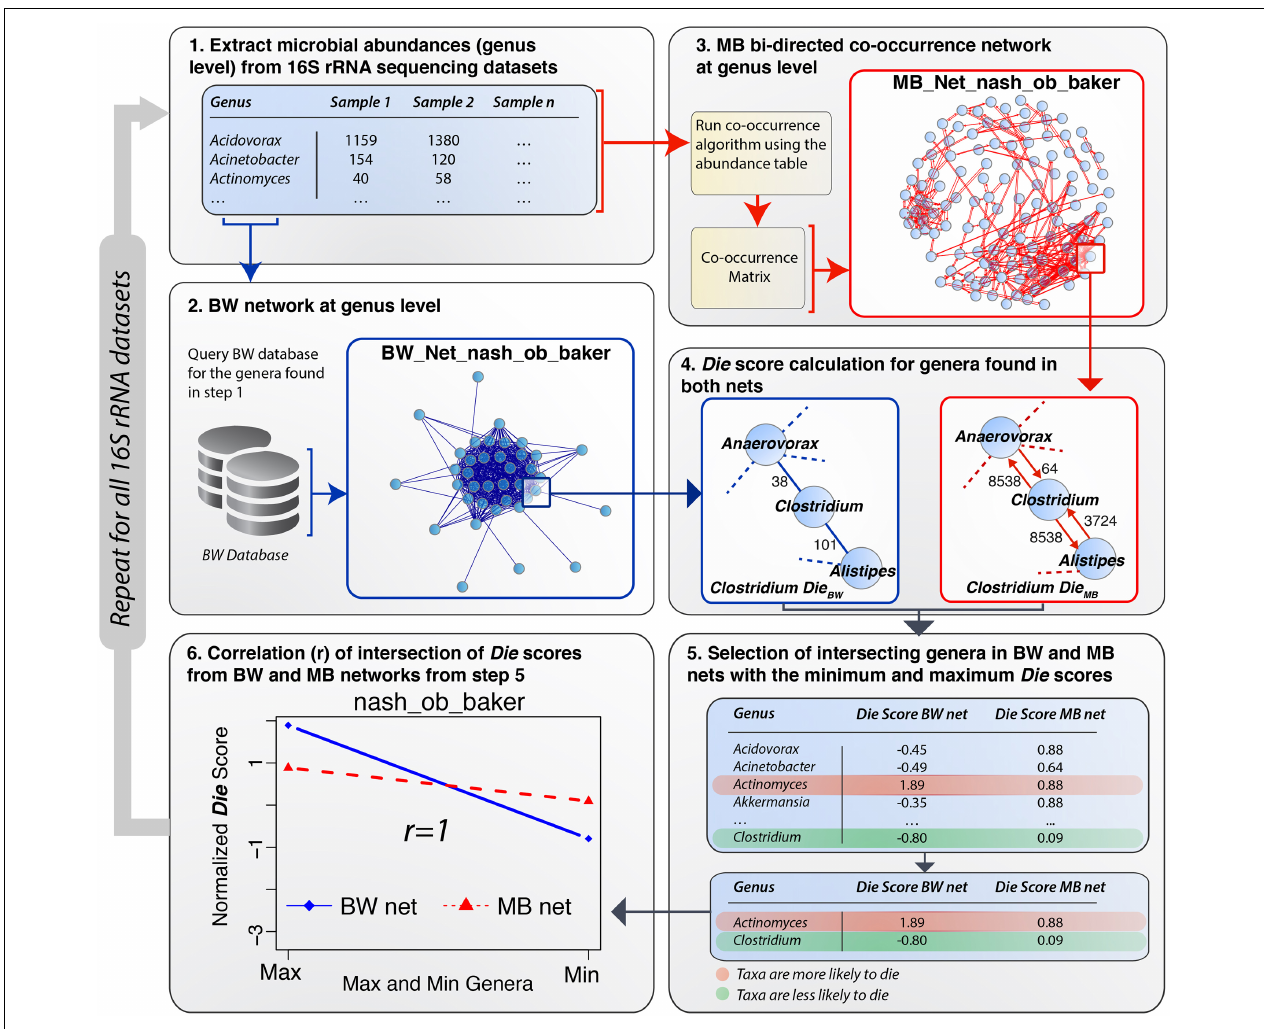
FIGURE 3 | Schematic workflow of the BW validation process. (1) A list of microbial genera was extracted from microbiome dataset (e.g., Zhu et al. (2013) NASH vs. Control gut MB dataset). (2) The BW database was queried using this list and the relevant BW network was constructed from the results obtained from this query. (3) A MB co-occurrence bi-directed network using a rho = 0.4 and p- value = 0.05 was constructed from the abundance table for the case study dataset. (4) Die scores were calculated for both networks and normalized by subtracting the mean and dividing by the standard deviation. (5) Some bacterial genera were not included in the BW database and therefore only the intersection of Die scores (full list in Supplementary Table 3 ) from both networks was taken into consideration in step 5. The rows in the table are highlighted in red (maximum, positive Die score) and green (minimum, negative Die score), following the legend shown in the bottom right panel. The transition from red to green denotes genera, which are more or less likely to die, respectively. (6) Pearson’s correlation coefficient was calculated for the BW min/max Die scores obtaining an r- value of